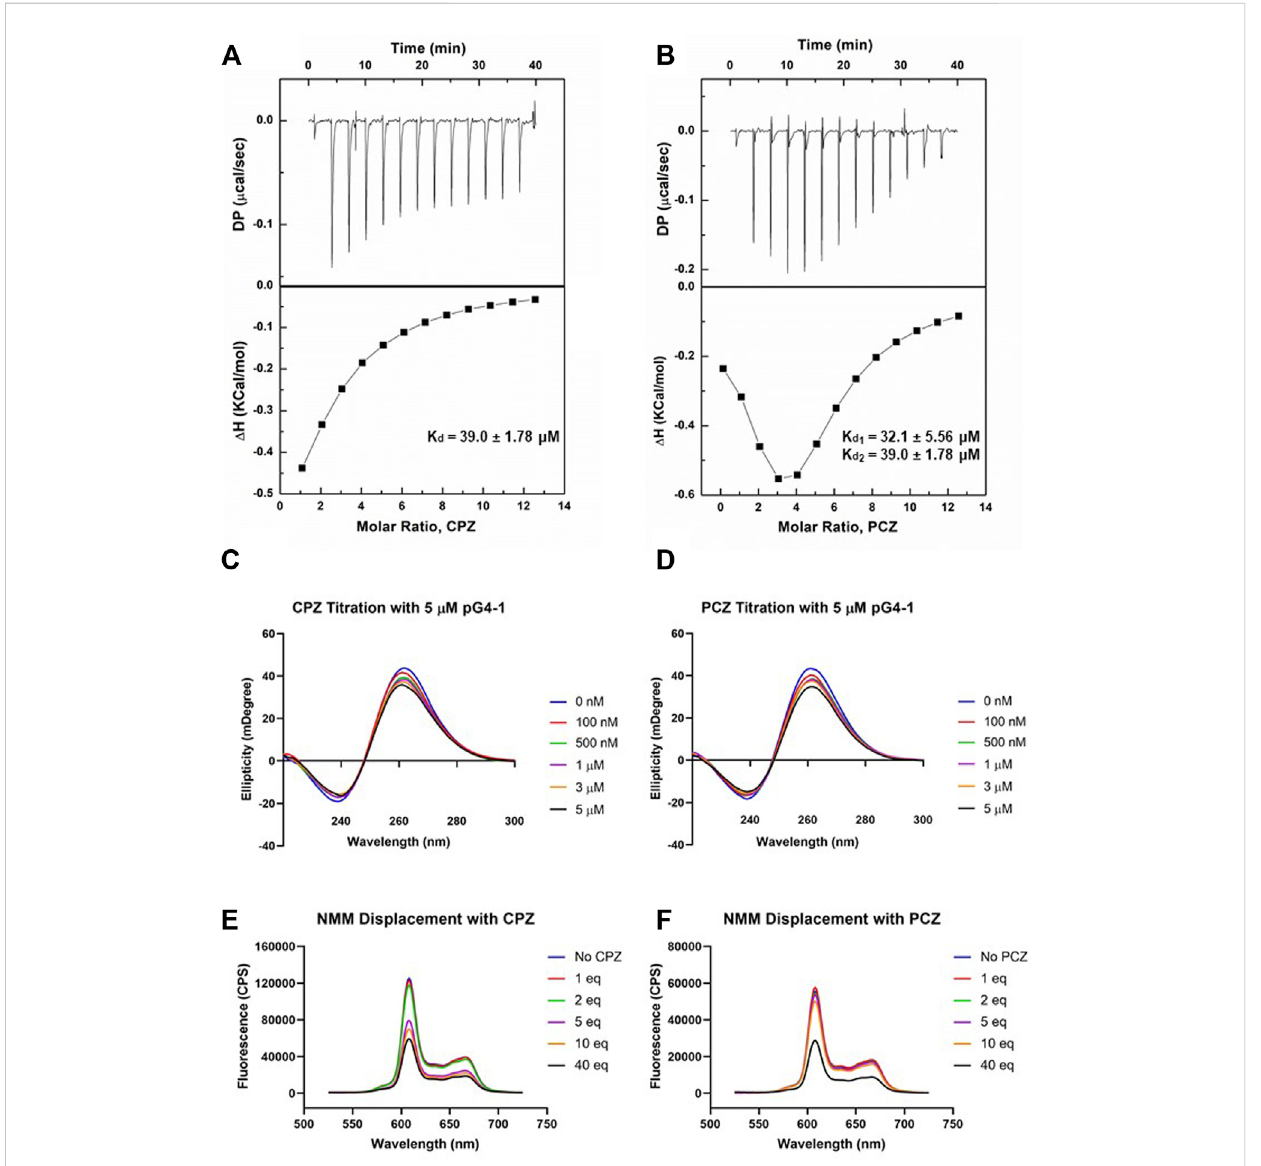
FIGURE 3 FDA approved drugs CPZ and PCZ can bind to pG4-1. Isothermal titration calorimetry (ITC) pro fi les for the titration of CPZ (A) or PCZ (B) with ORF1 pG4-1. The upper panels show sequential injection of the ligands into ORF1 pG4-1; fi tted data of integrated heat values after correction for heat of dilution plotted against molar ratio shown in lower panels; dissociation constants mentioned in the lower panel. CD spectra of ORF1 pG4-1 with increasingconcentrationofCPZ (C) orPCZ (D) .Fluorescencespectraof1 μ MofNMMinpresenceof1 μ MofORF1pG4-1withincreasingmolarratio of CPZ (E) or PCZ (F)